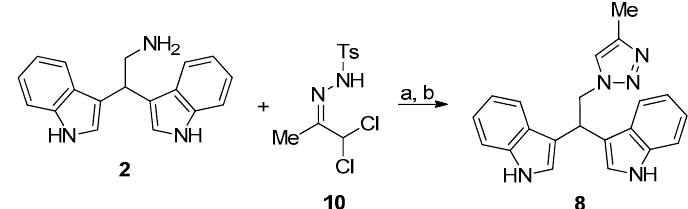
Figure 5. Reaction conditions: ( a ) N , N -diisopropylethylamine, ethanol, 0 ◦ C, 10 min; and, ( b ) 10 , acetonitrile, 0 ◦ C, RT, 2 h.